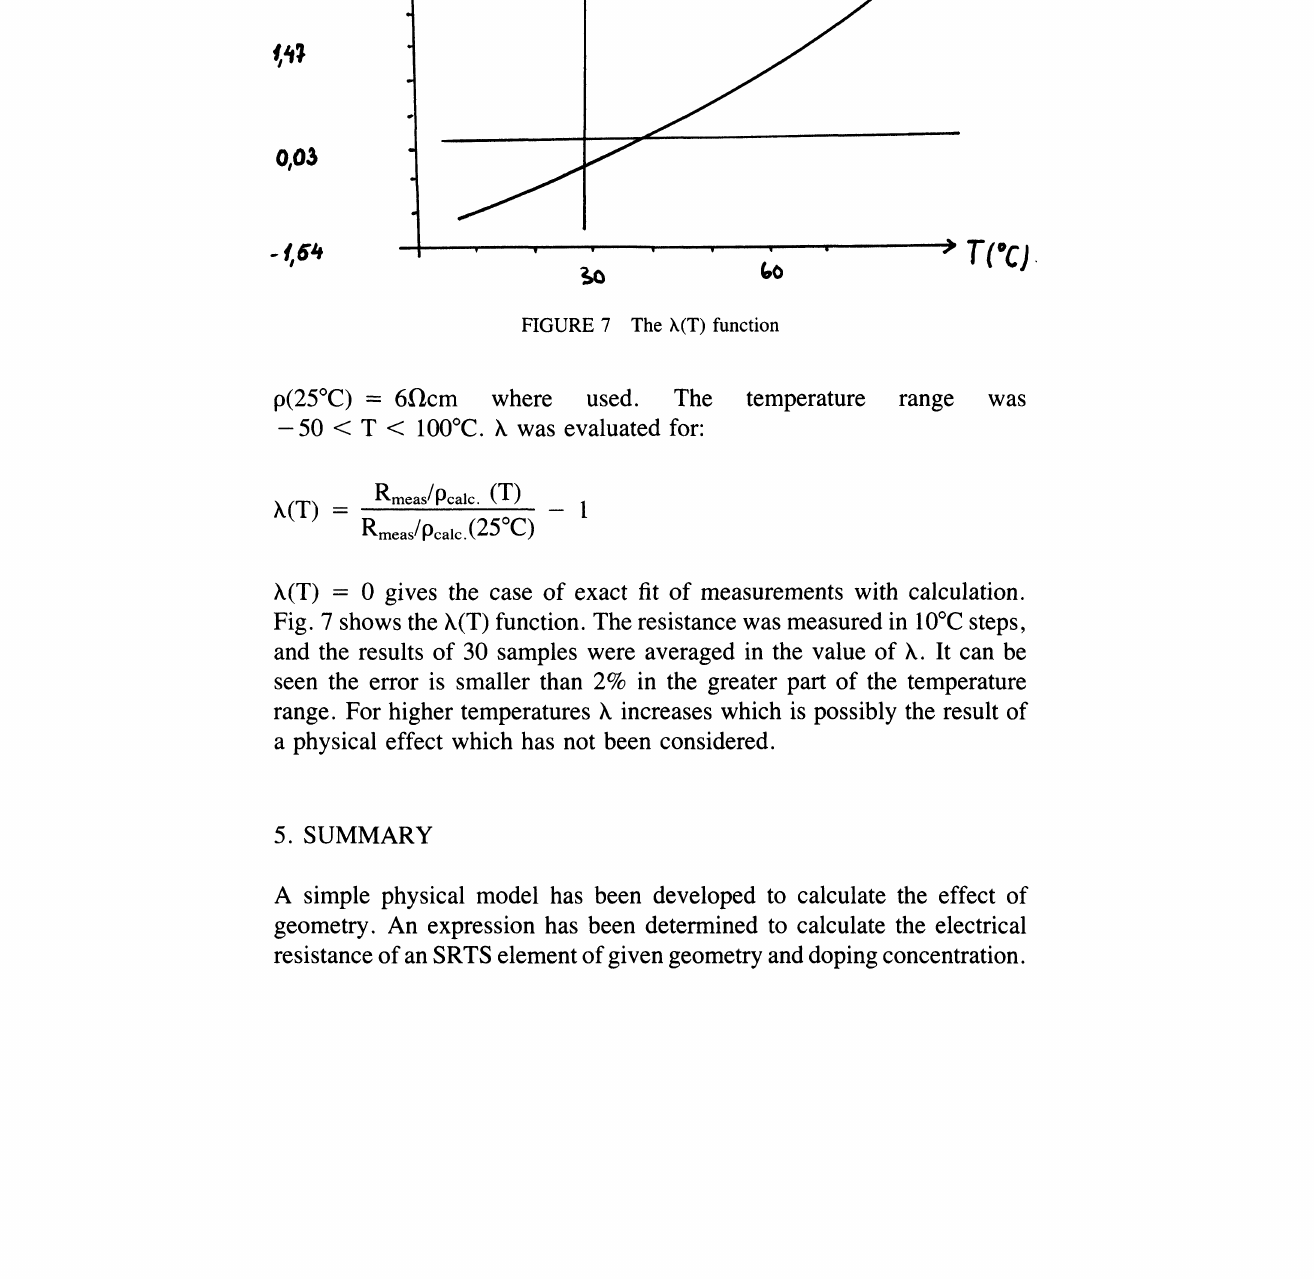
FIGURE 7 The h(T)